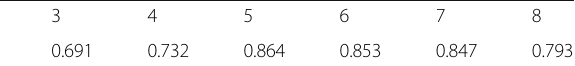
Table 1 Examples of traffic accident observation samples Traffic police brigade